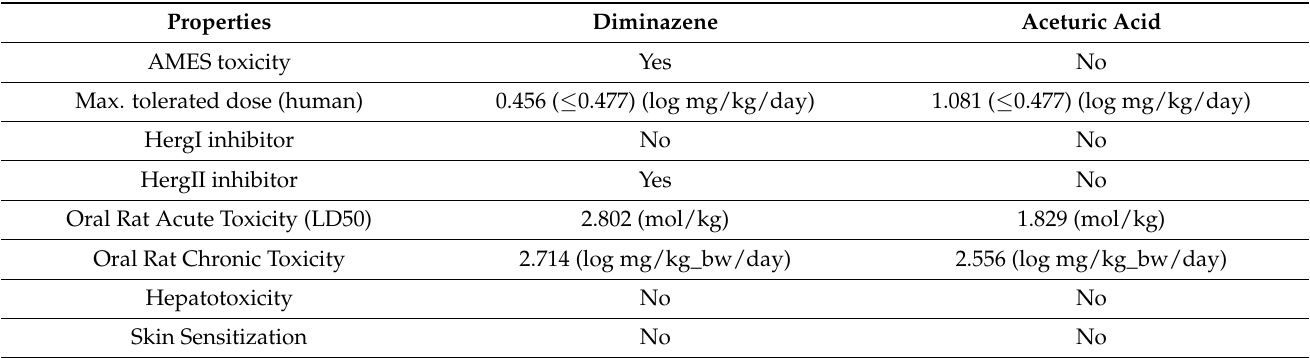
Table 8. The toxicity results of diminazene and aceturic acid, according to